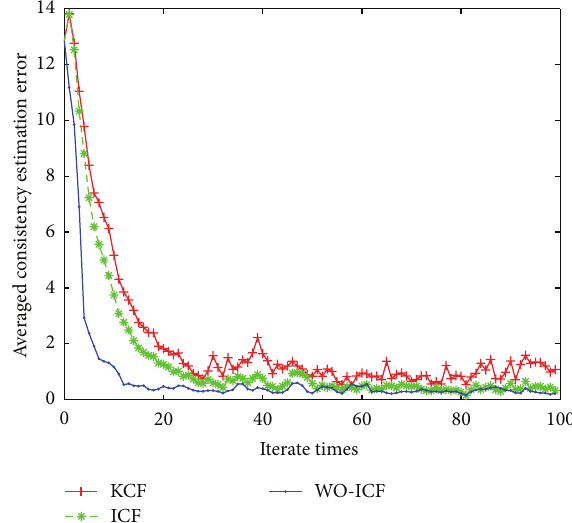
Figure 4: The averaged consistency estimation errors of different